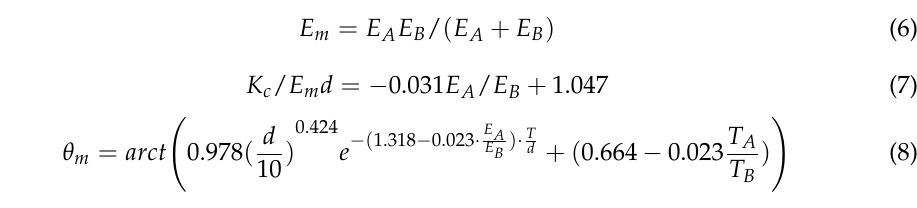
The area of the pressurized layer of the connected parts is shown in Equation (9).